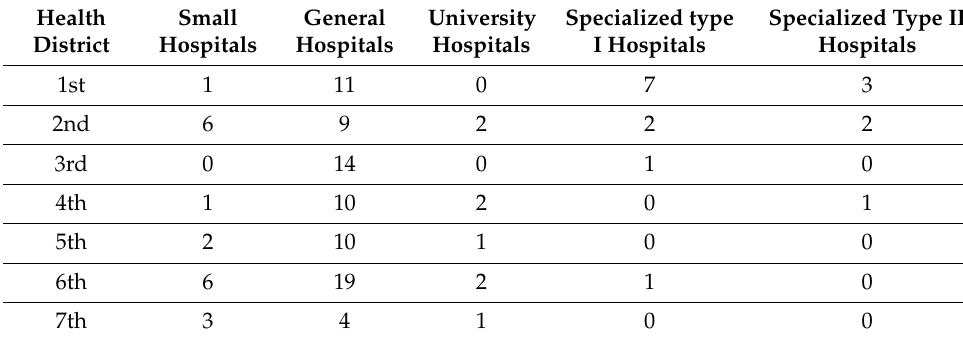
Table 1. Hospital distribution in Greece per health district and hospital